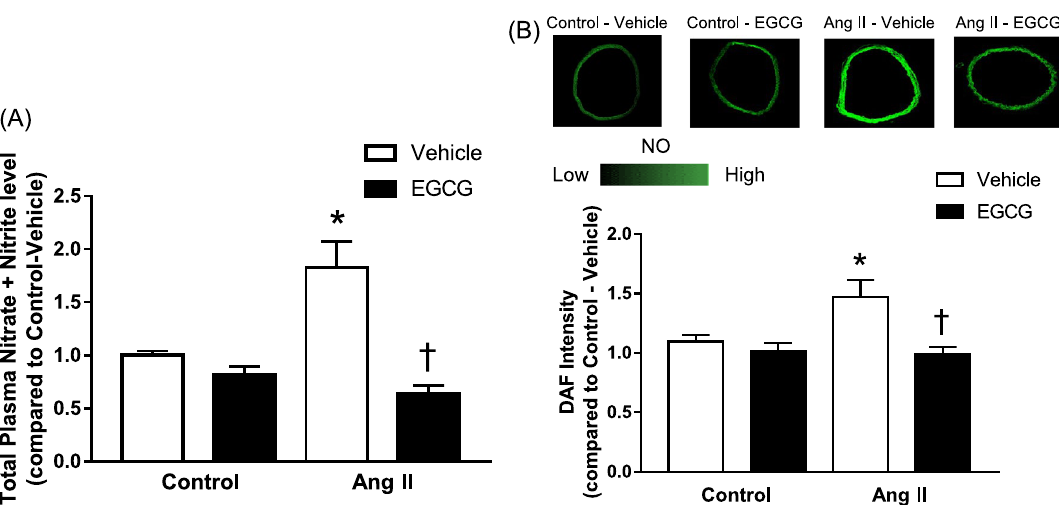
Figure 3. Plasma nitrite level ( A ) and vascular NO level ( B ) of control and angiotensin (Ang) II-infused hypertensive C57BL/6J mice, with or without in vivo treatment with epigallocatechin gallate (EGCG) measured using commercially available kit and DAF-FM staining, respectively. The upper panel shows representative fluorescence images of the stained aortae and the bottom panel shows the quantified fluorescence intensity ( B ). Data are expressed as means Data are expressed as means ± SEM (n = 5–6). *p ≤ 0.05 compared to control— vehicle; † p ≤ 0.05 compared to Ang